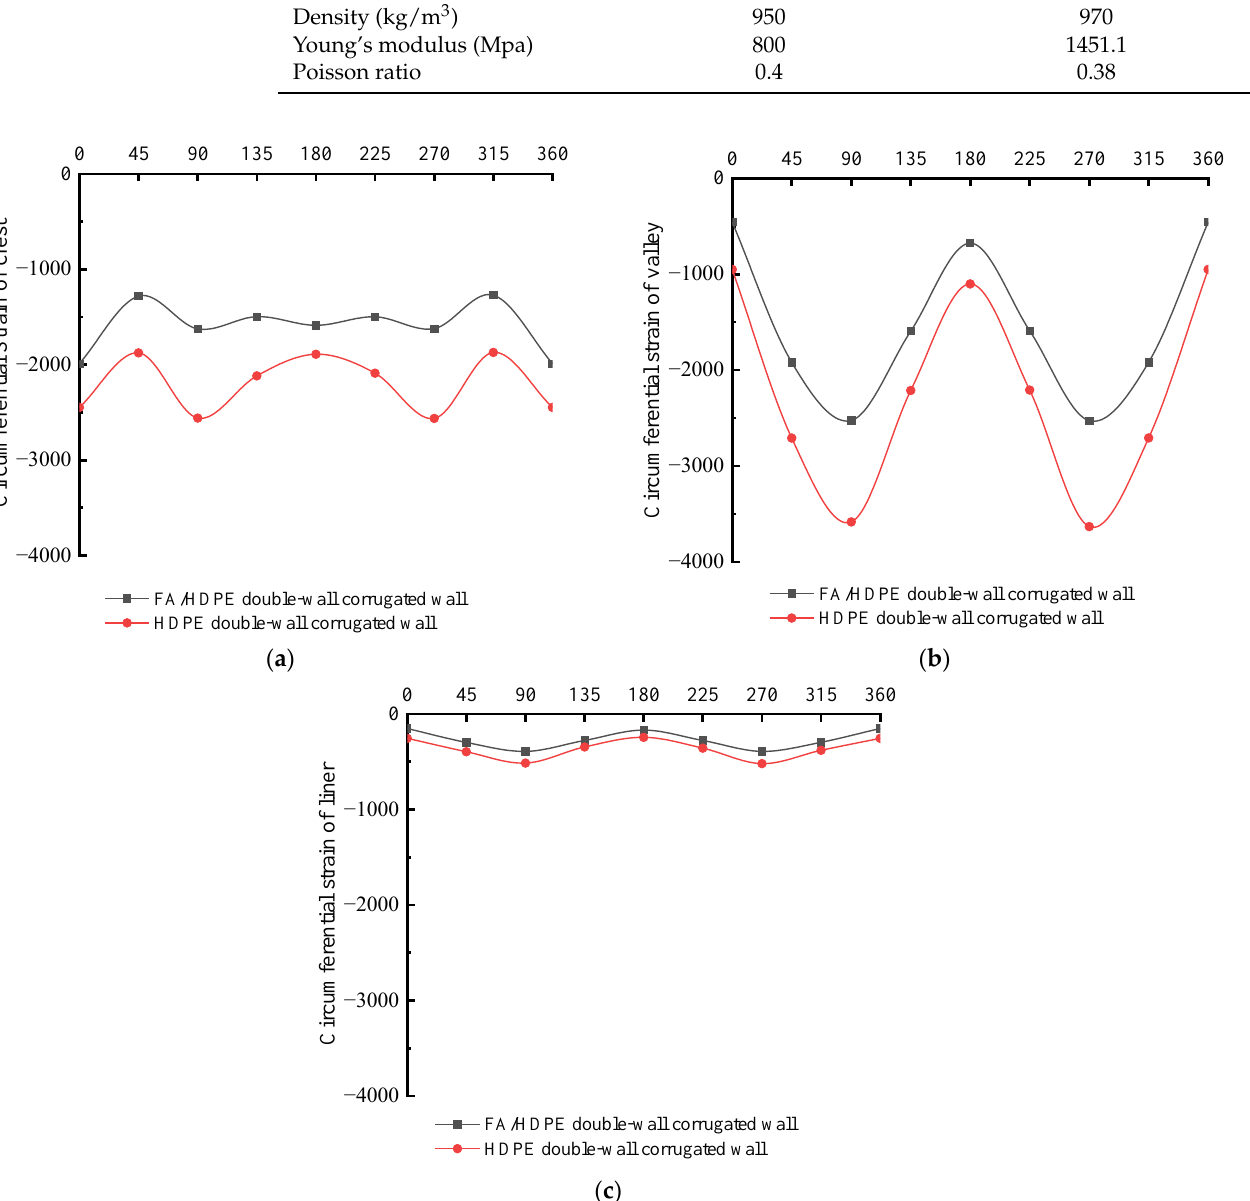
Figure 12. Comparison of circumferential strain between HDPE and FA/HDPE of double-wall corrugated pipes. ( a ) Crest; ( b ) Valley; ( c )